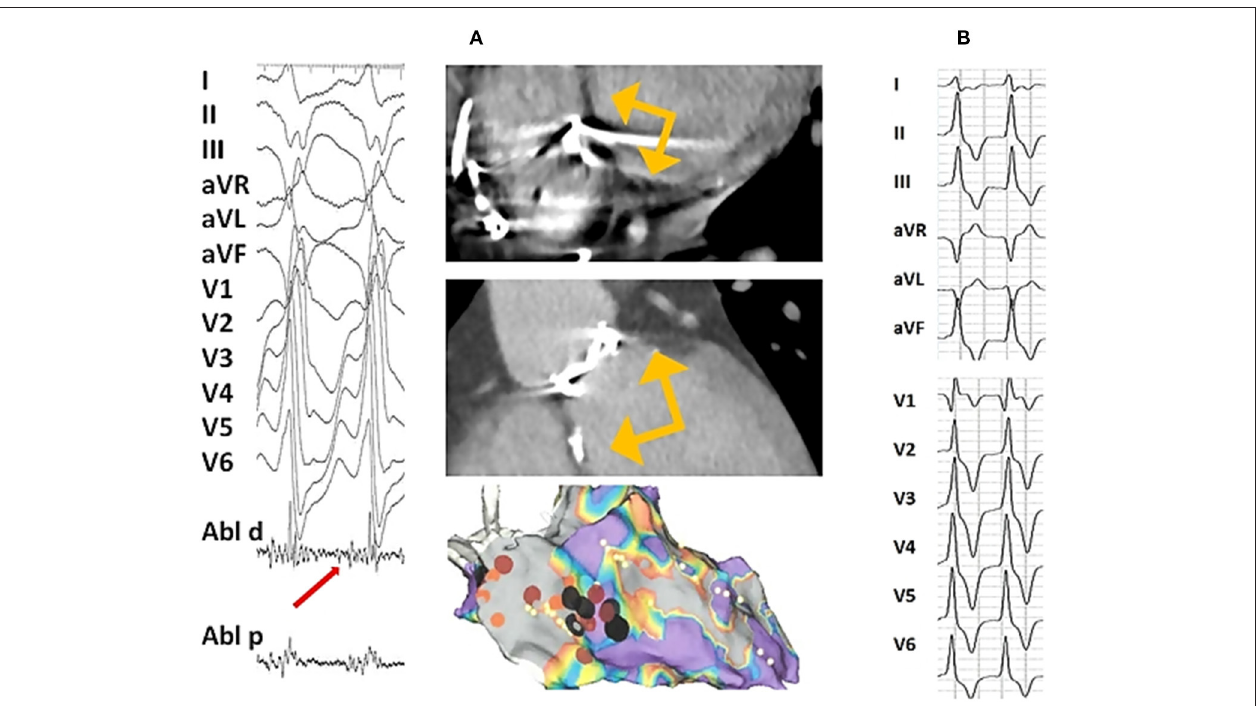
FIGURE 2 | Twelve-lead surface ECG of ventricular tachycardia following aortic valve replacement and representative of CT scan and electroanatomic substrate: (A) In a 23 year-old man with congenital aortic stenosis treated with balloon aortic valvotomy followed by surgical aortic valve replacement with mechanical Carbomedics 21 prosthesis at the age of 7 years and implanted with a double chamber pacemaker for post-operative complete atrio-ventricular heart block. At the age of 23 years, he was admitted for a sustained symptomatic ventricular tachycardia leading to upgrading his pacemaker to implantable cardioverter defibrillator. Cardiac CT scan (on the top : coronal oblique left ventricular outflow tract and basal short-axis views) performed prior to electrophysiology study showed a periaortic left ventricular myocardial thinning localized to anteroseptal, inferoseptal and inferobasal LV segments (yellow arrows) consistent with a periaortic scar. Bipolar endocardial electroanatomic map (on the bottom, antero-posterior view) displayed periaortic inferoseptal low-voltage abnormal area (in gray). The clinical monomophic VT with a right bundle branch block and superior axis configuration was induced at the time of electrophysiology study with programmed electrical stimulation. The earliest recorded activation signal (50ms to the onset of the surface QRS recorded on distal tip of the ablation catheter, red arrow) identified at the edge of the low voltage inferoseptal area was targeted with ablation (black dots) allowing for VT interruption. (B) A 18 year-old man with congenital severe bicuspid aortic valve stenosis leading to aortic valvuloplasty at the age of 5 and 16 years followed by surgical aortic valve replacement with mechanical 21 St Jude prosthesis at the age of 17 years. One year after aortic valve replacement an asymptomatic non-sustained monomorphic VT was recorded on a 24h Holter and exercise treadmill test. 12-lead ECG displayed a Rs morphology in D1, qR pattern in V1 and a lack of precordial transition suggesting aortomitral continuity